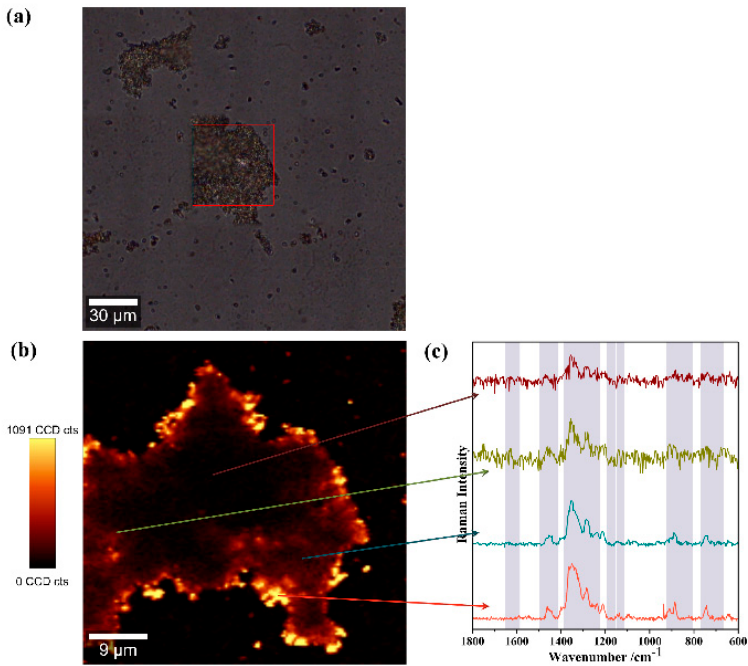
Figure 9. ( a ) Optical image of the MNP-AuNS hybrid substrates after contact with TC, with the Raman scanned area marked in red; ( b ) Raman image obtained using the integrated intensity of the Raman band at 1347 cm − 1 in the SERS spectrum of TC (10 µ M) using the MNP-AuNS as substrates; and ( c ) selected SERS spectra of TC collected at different points as shown by the arrows. The vertical bar shows the colour profile with the relative intensity scale.